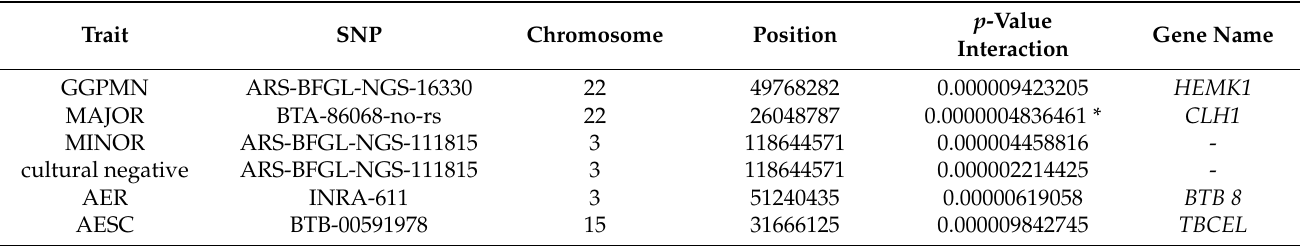
Table 3. Genome-wide significances for interactions between SNPs and housing systems and annotated potential candidate genes for differential somatic cell fractions and for mastitis